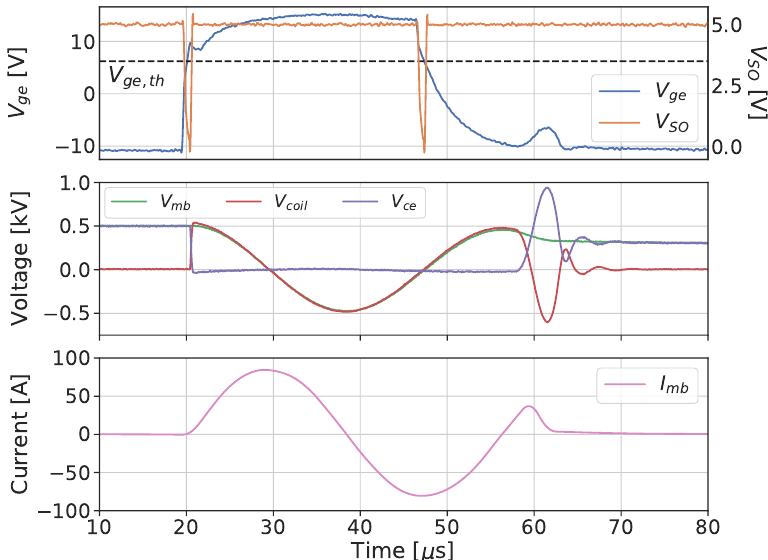
Figure 29. Continued flow of current after end of second half cycle in the UW HiPeR-PIT discharge circuit, resulting in voltage ringing and loss of charge from the energy storage